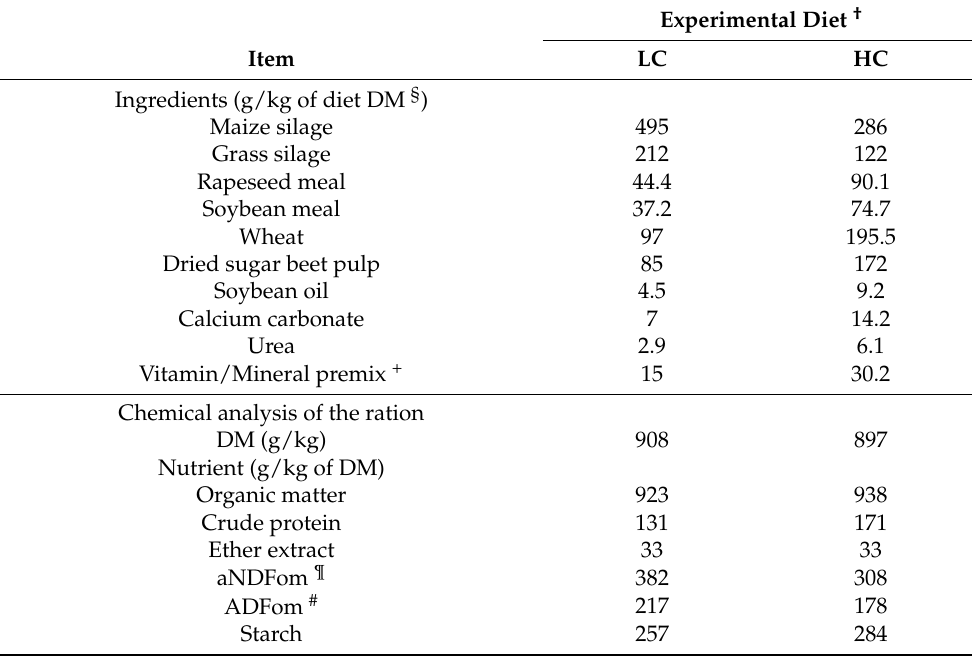
Table 1. Ingredients and chemical composition of the experimental